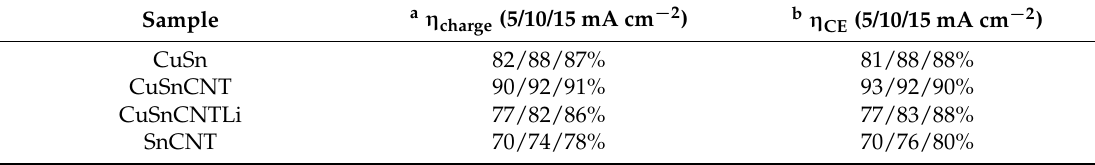
Figure 8. Charge efficiency measurements at 5, 10 and 15 mA cm − 2 of CuSn ( a ), CuSnCNT ( b ), CuSnCNTLi ( c ) and SnCNT ( d ). Table 4. Efficiency comparison.